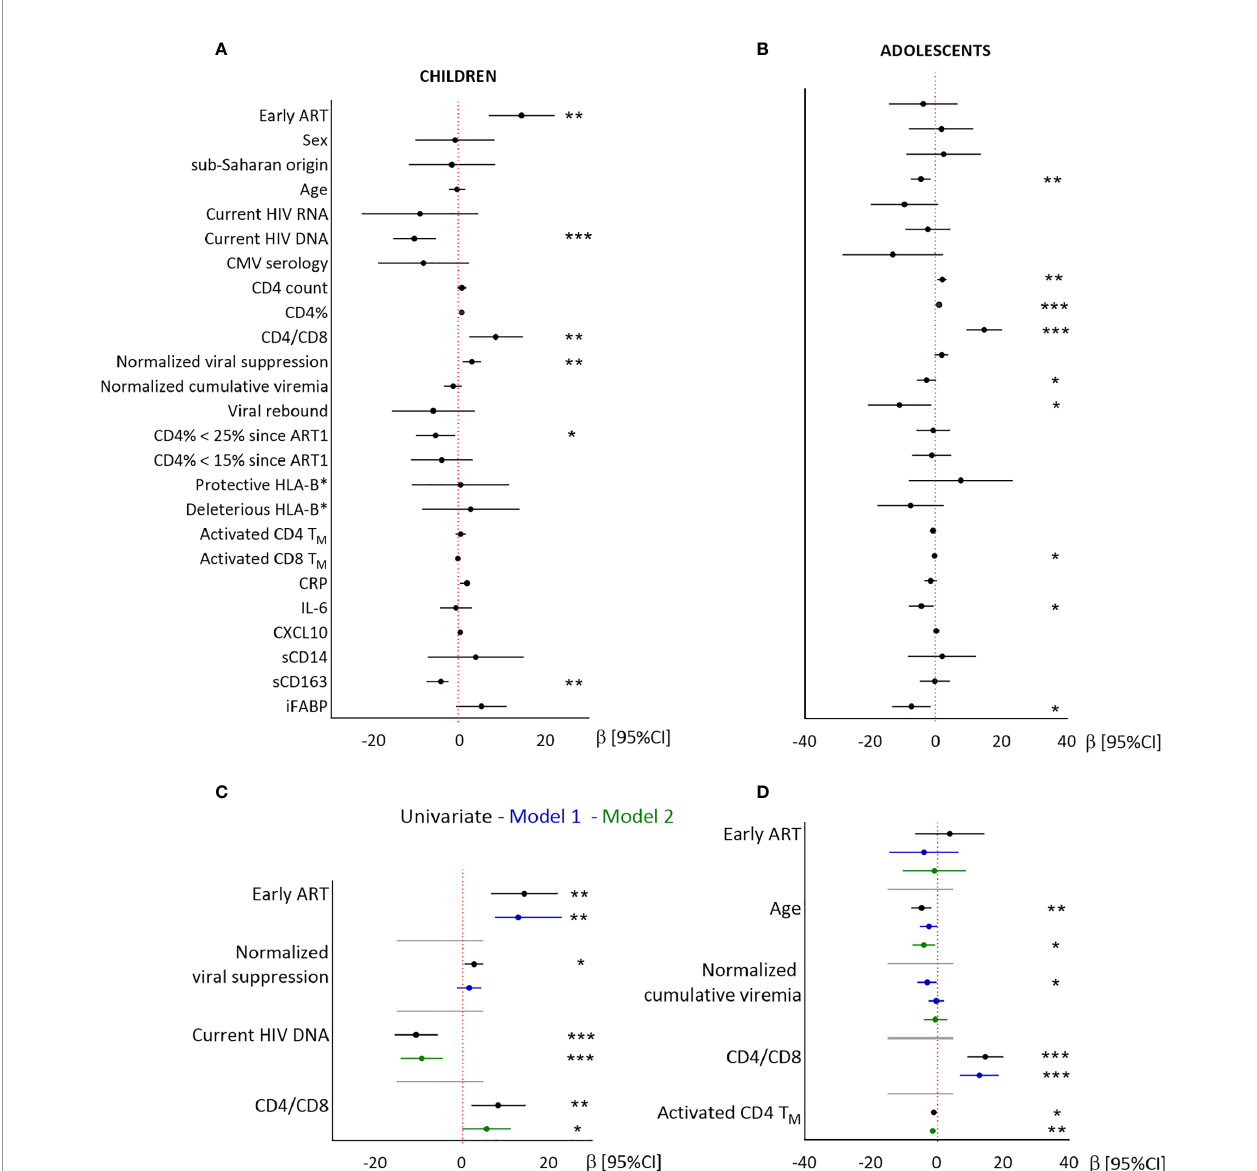
FIGURE 4 | Linear regression analysis of the associations between CD8T N and demographic, virological and immunological factors in children and adolescents. Results from univariate (A, B) and multivariate (C, D) linear regressions are presented as estimates ( b ) and 95% con fi dence intervals. Signi fi cant associations are indicated by symbols (* p < .05; ** p < .001; *** p < .0001). Multivariate analysis included the covariables indicated on the plot. Estimates are given per year, per 0.1 units of normalized viral suppression, per unit of normalized cumulative viremia, per point of CD4/CD8 ratio, and per 1% of activated CD4T M